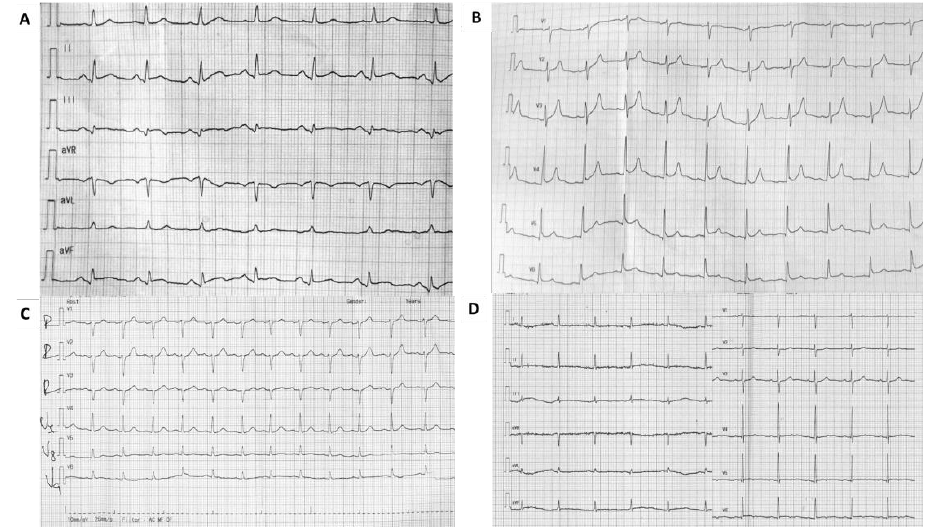
Figure 2. ST-segment evolution. ( A – C ) Initial electrocardiogram (ECG) at the emergency department, ST elevation in inferior and lateral leads. ( D ) ECG at discharge, flat ST segment with biphasic T waves.